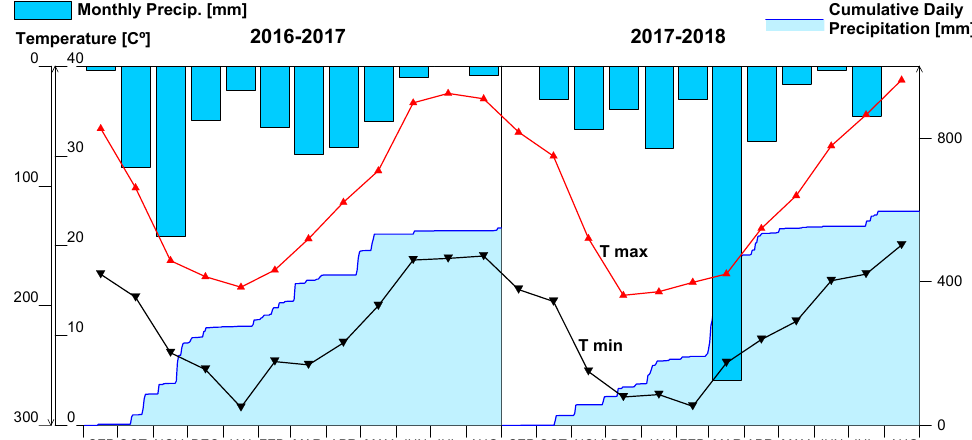
Figure 2. Monthly average of maximum and minimum temperature, monthly precipitation, and annual cumulative precipitation during the two-monitoring seasons.